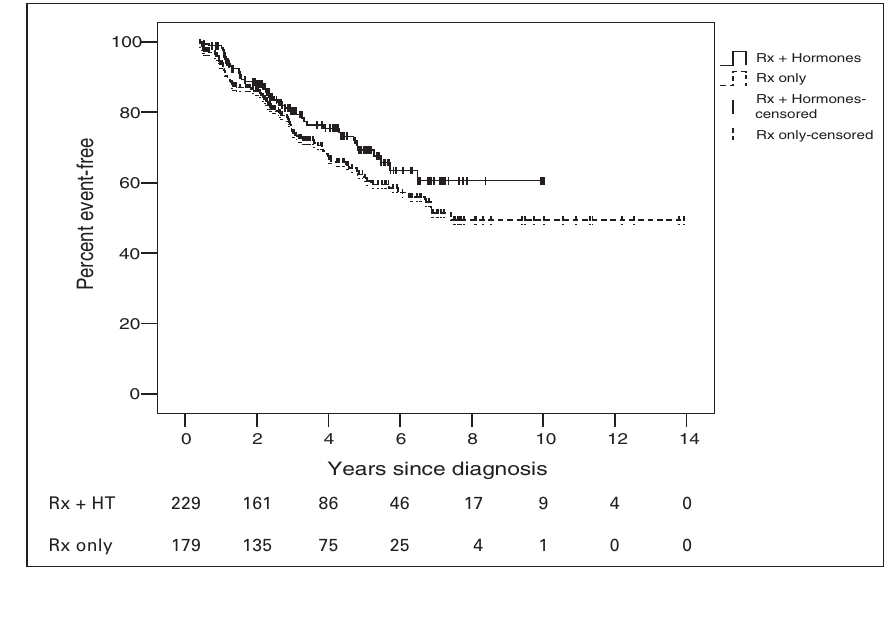
starting RT (28 patients) correlated with a trend for a better bDFS (but not OS) than patients with higher PSA values at the time of RT (151 pa- tients) (p = 0.085) . Overall survival was similar for patients treated with or without pelvic RT, while bDFS did not benefit from pelvic irradiation either, with a better outcome for patients treated exclusively to the prostate only on univariate analysis (p = 0.05), probably translating the more favourable risk of the later patients. The 5-year probability of ≥ grade-2 late uri- nary and low-GI toxicities (moderate to severe, requiring medical or surgical interventions) was ly, for the whole group of patients in the study (fig. 3a and 3b). In addition, a 5-year probability of irreversible failure of erections (unresponsive to sildenafil or analogues, grade 3) was observed in 57% (±4%, SE) of patients, as shown in fig.